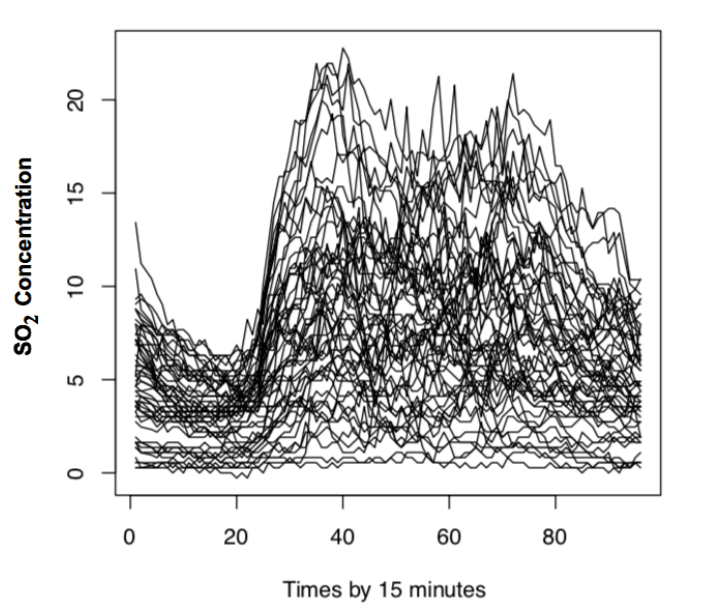
Figure 4. The daily curves of the SO 2